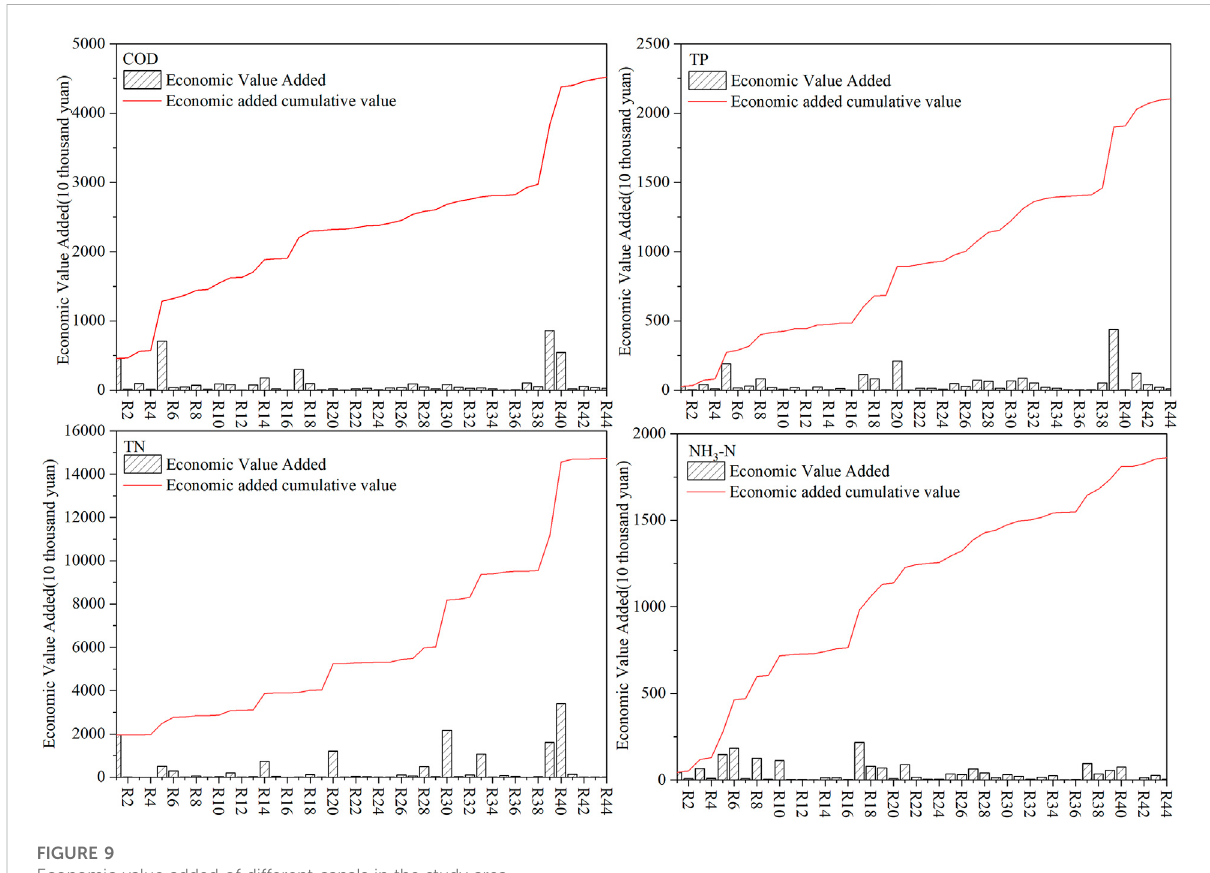
FIGURE 9 Economic value added of different canals in the study